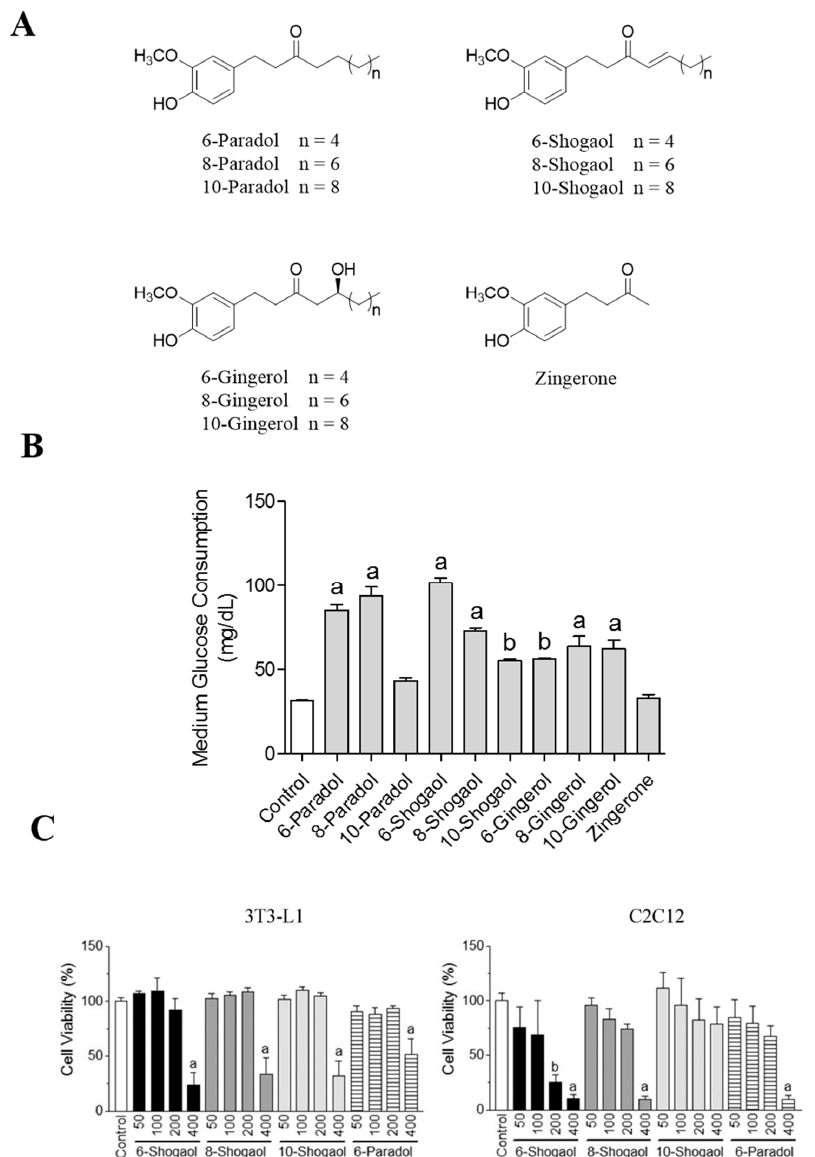
Figure 1. Ginger non-volatile pungent components promote medium glucose consumption by 3T3-L1 adipocytes. ( A ) Chemical structures of ginger’s non-volatile pungent compounds used in this study; ( B ) Medium glucose consumption in 3T3-L1 adipocytes revealing the effect of ginger non-volatile pungent compounds (100 μ M). The 3T3-L1 adipocytes were treated with the compounds without insulin in 450 mg/dL D -glucose Dulbecco's modified Eagle's medium (DMEM). After 24 h, the remaining glucose concentration of the medium was measured using chemistry analyzer. The data represent the amount of glucose in mg/dL consumed by the cells after 24 h of treatment. Data reflect the mean ± SEM of three independent experiments. a p < 0.001 and b p < 0.01 indicate a significant difference compared with the control group; ( C ) Cell viability of 3T3-L1 ( left ) and C2C12 ( right ) cells after the treatment with 50–400 μ M of 6-paradol and 6-, 8-, 10-shogaols for 24 h. The cell viability was detected using water soluble tetrazolium salt (WST-1) reagent (Roche, Basel, Switzerland). Values are the mean ± SEM ( n = 4). a p < 0.001 and b p < 0.01 compared to the control.